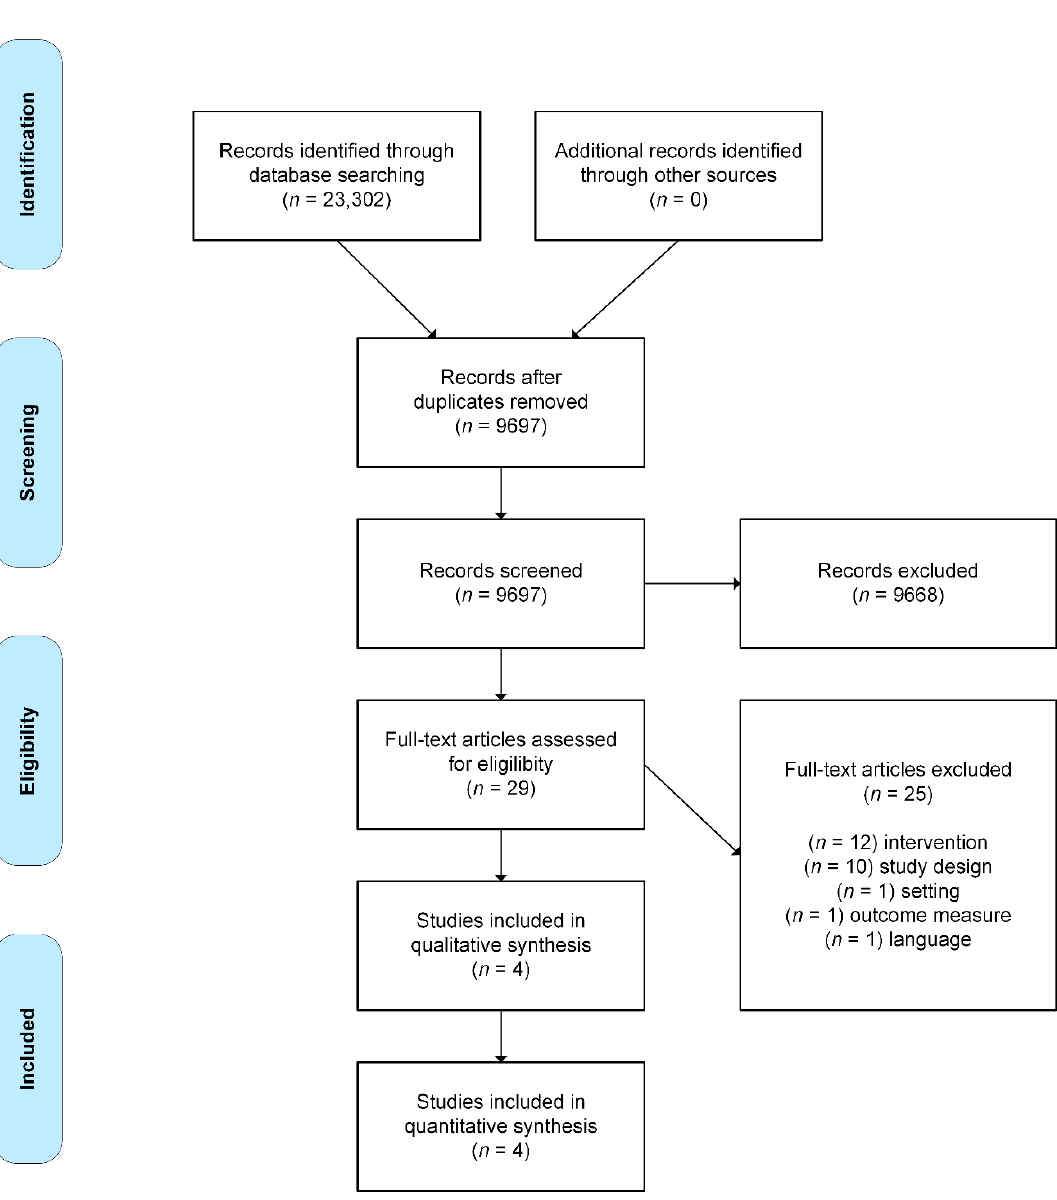
Figure 1. Flow chart of the study selection process, adapted from Moher et al. [18].